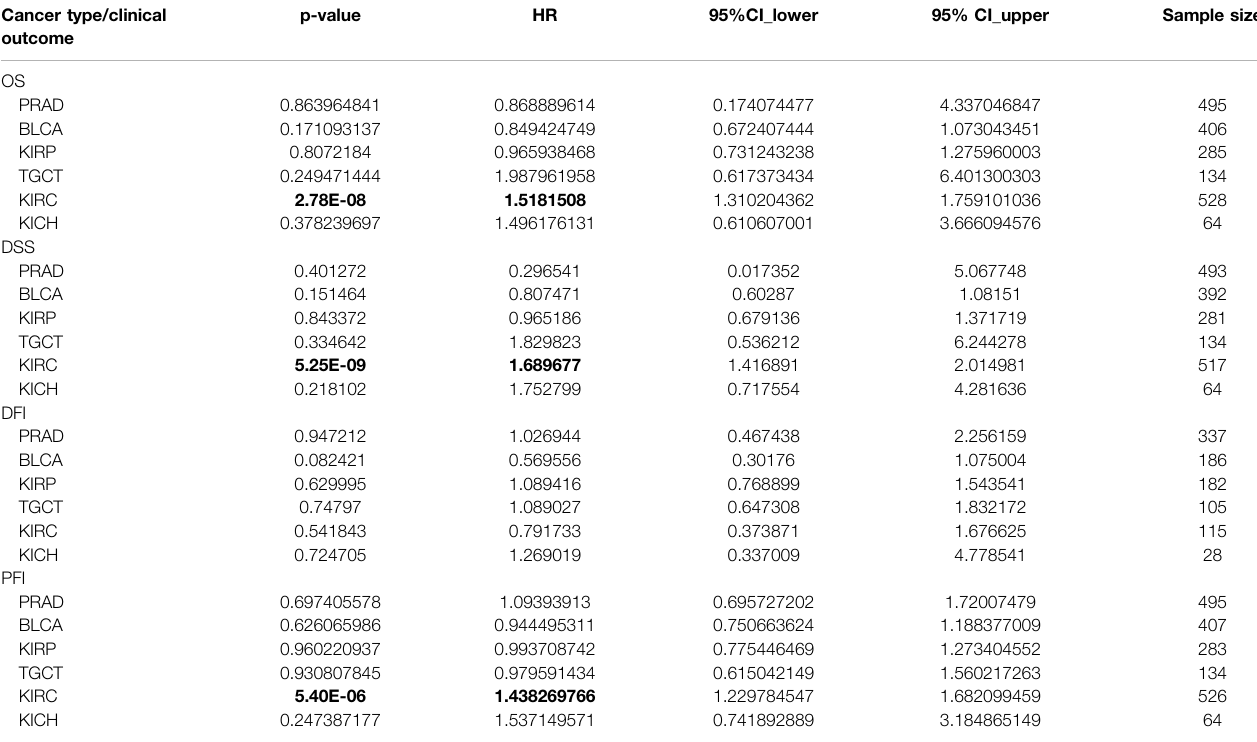
TABLE 1 | Pooled univariate analysis of hepcidin in male genitourinary system tumors. Cancer type/clinical